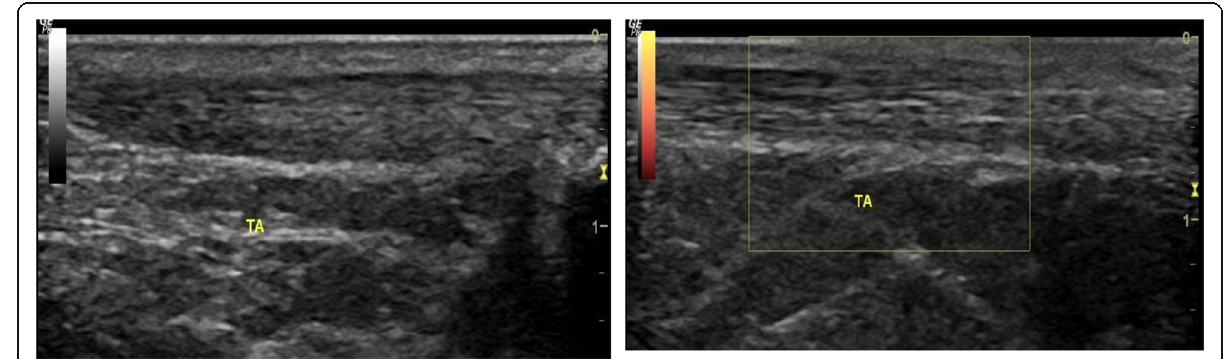
Fig. 4 a Greyscale ultrasound longitudinal scan over right Achilles tendon (TA) post ESWL treatment of above described patients shows improved thickness and heterogenicity of fibrillar pattern. b Power Doppler scan of same patient showing negative PD inside tendon after